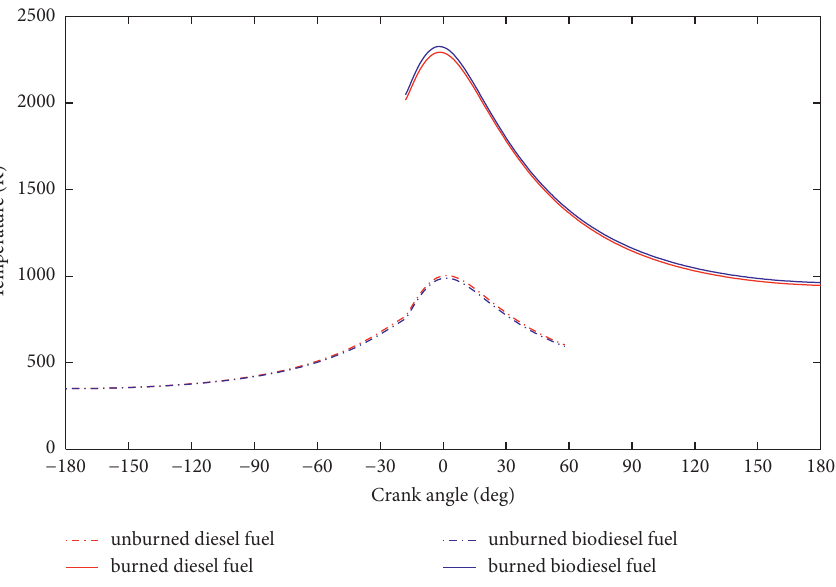
Figure 8: Temperature comparison of biodiesel and diesel